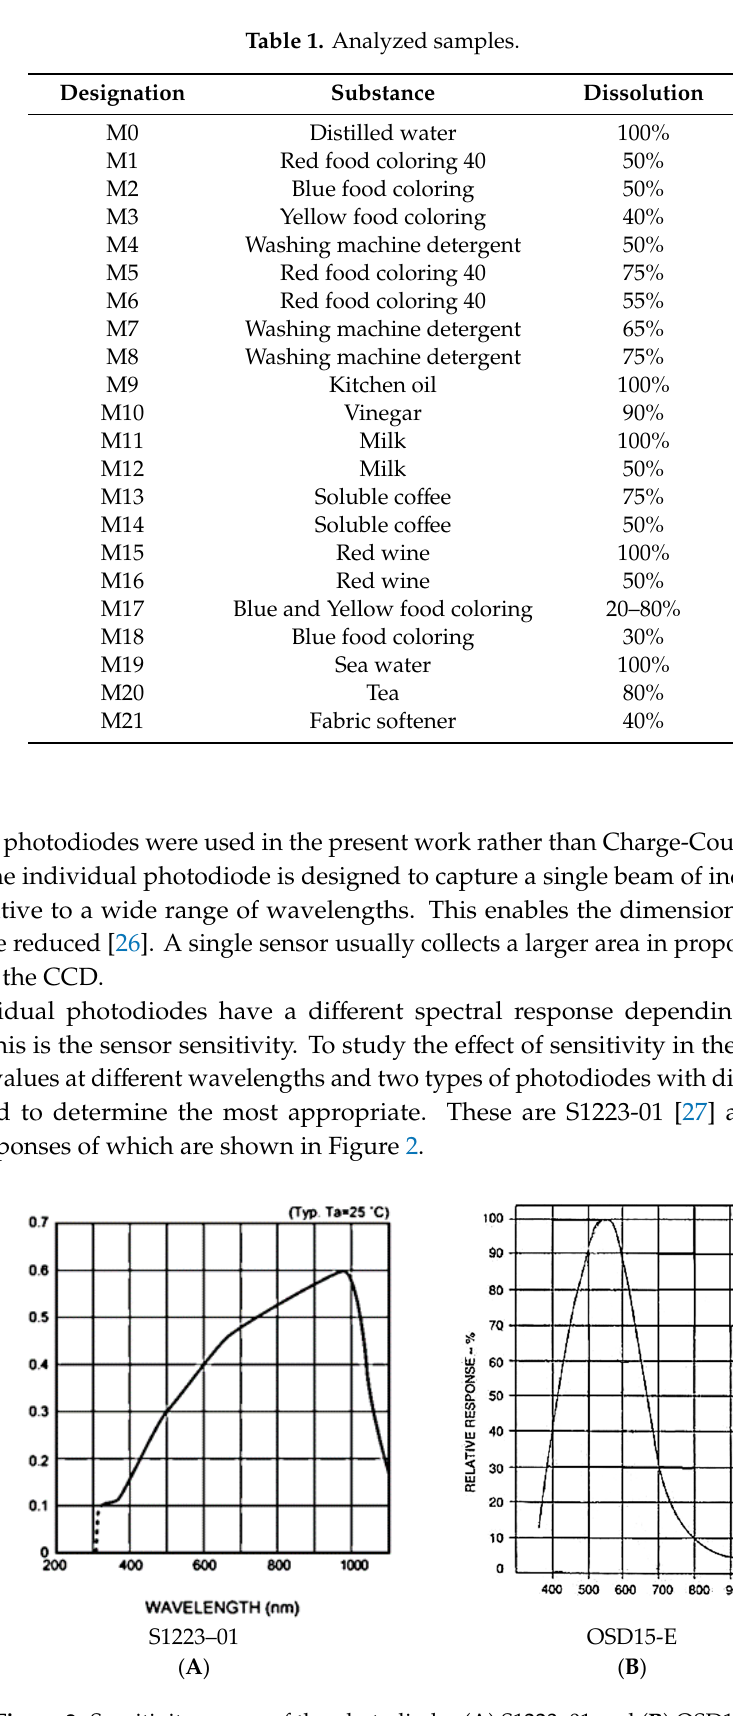
Figure 2. Sensitivity curves of the photodiodes ( A ) S1223–01 and ( B ) OSD15-E.